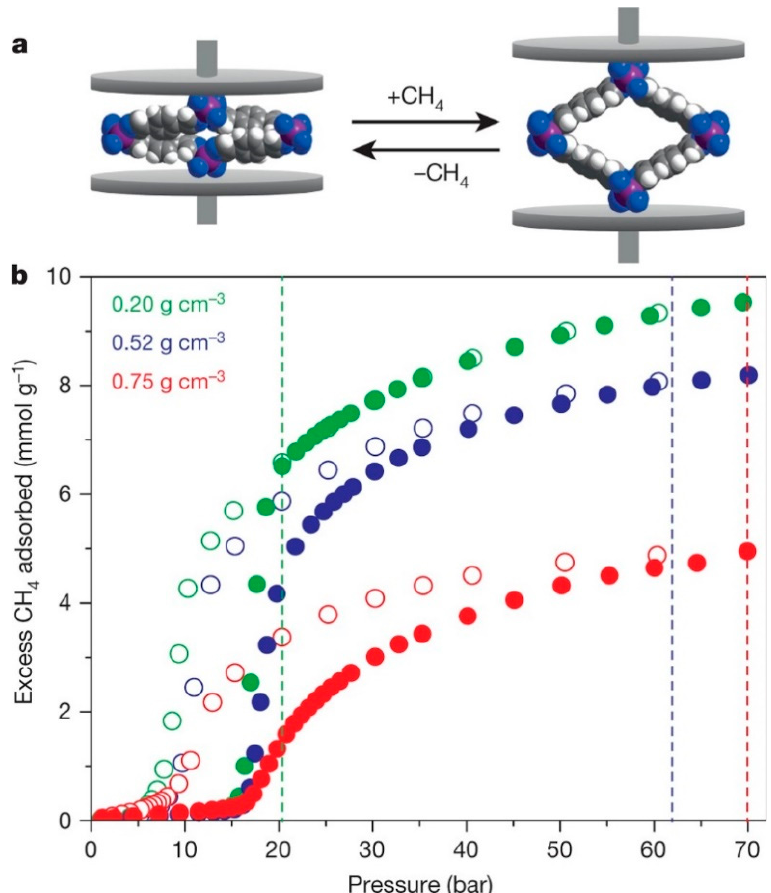
Figure 7. Methane storage in flexible Co(bpd) from a pressure of 0 to 70 bar. ( a ) Collapsed and expanded Co(bpd) represented by a space-filling model. Atom color codes: carbon, grey; nitrogen, blue; cobalt, purple; and hydrogen, white. ( b ) Excess methane adsorption isotherms for Co(bpd) at 298 K at different applied external pressures at their corresponding densities. Adsorption-filled circle and desorption- open circles. Adapted with permission from Ref. [72]. Copyright 2015 Nature.